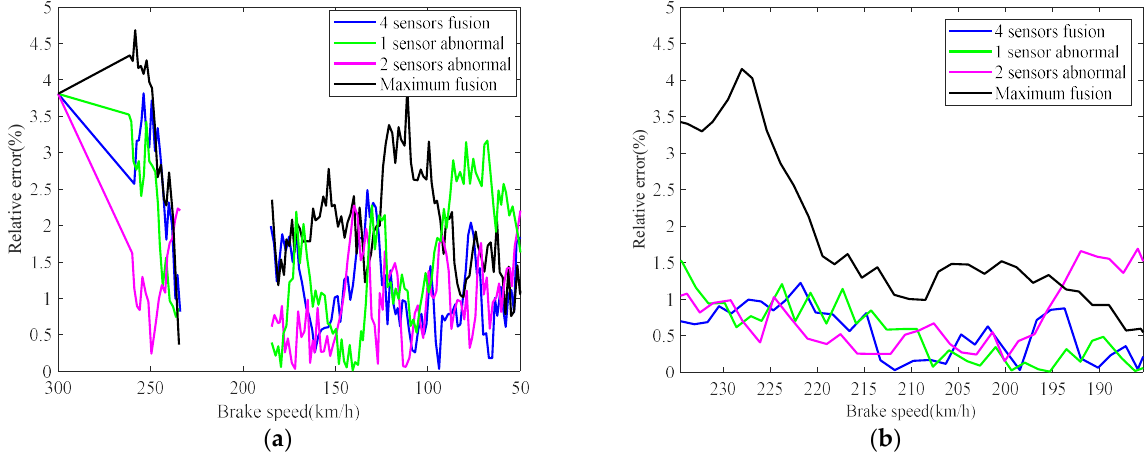
Figure 21. Identification relative errors of friction coefficient and adhesion coefficient: ( a ) friction coefficient; ( b ) adhesion coefficient.